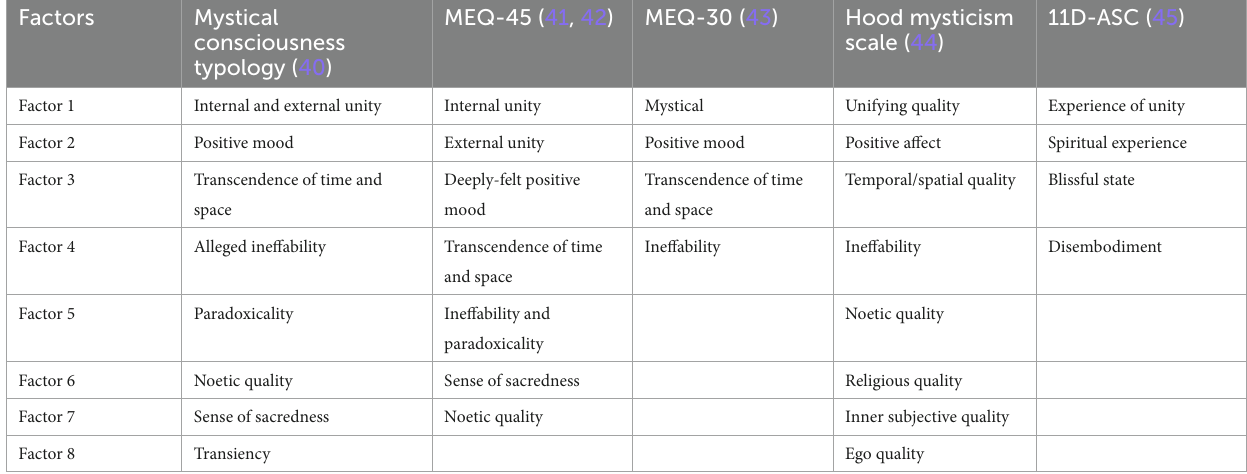
TABLE 1 The factor structure for each of the psychometric assessments used to measure mystical-type experiences as induced by psychedelic drugs.